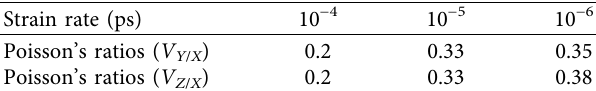
Table 4: Poisson’s ratio of amorphous system at three strain rates. Strain rate